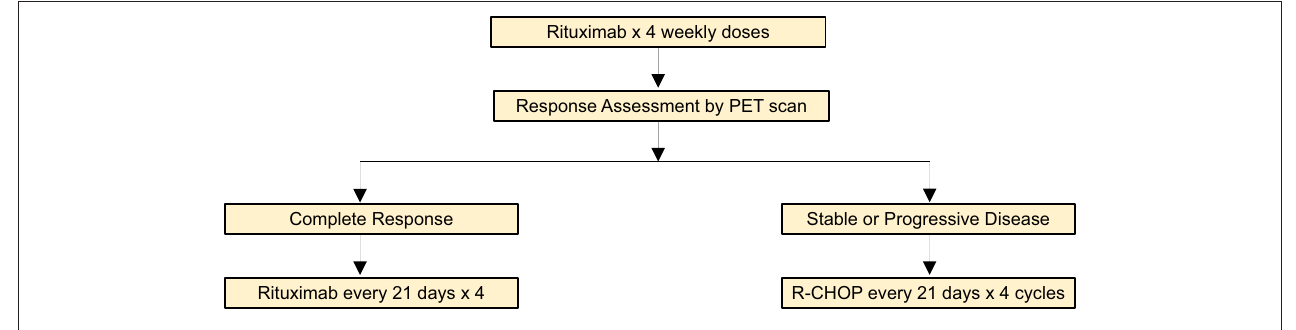
FIGURE 1 | Risk-adaptive treatment approach for DLBCL PTLD (31).